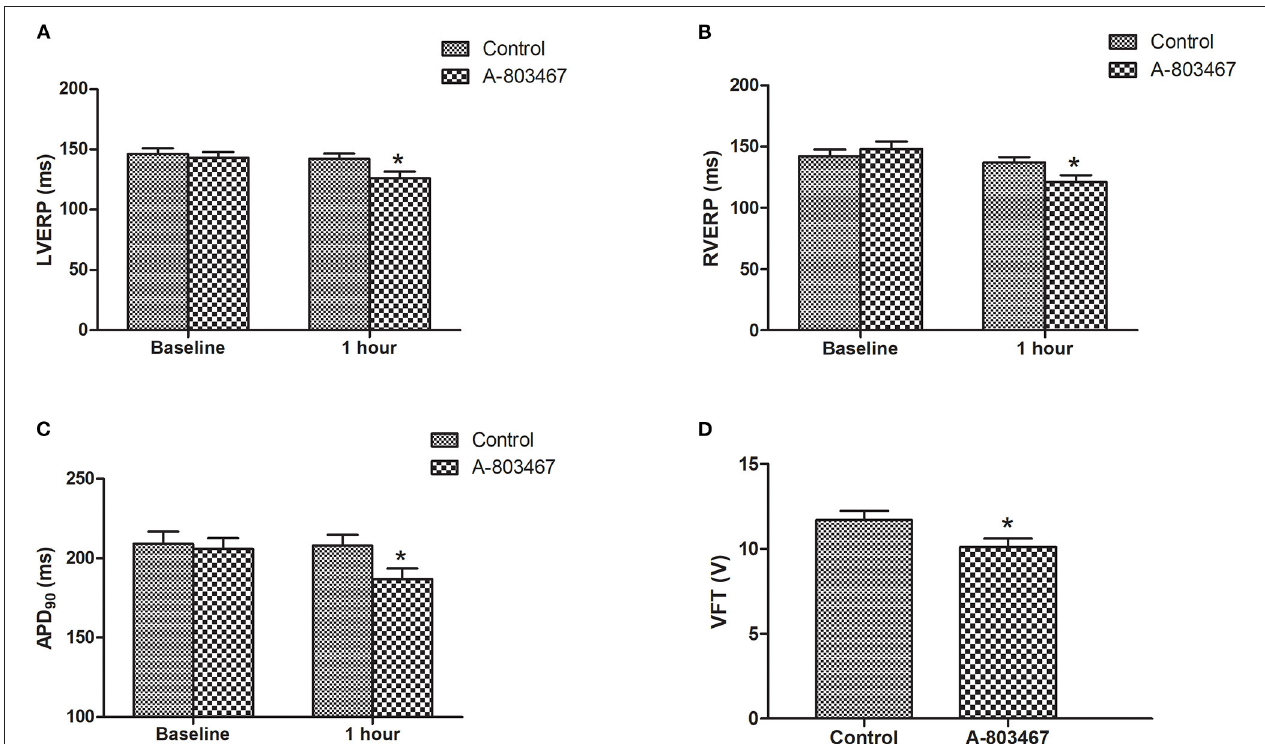
FIGURE 2 | Effects of A-803467 on Ventricular electrophysiology in the both two groups. (A) The left ventricular effective refractory period (LVERP) was decreased in the A-803467 group compared to control. (B) The right ventricular effective refractory period (RVERP) was decreased in the A-803467 group compared to control. (C) A-803467 significantly shortened 90% of action potential duration (APD 90 ) at 1h after LAD occlusion. (D) The ventricular fibrillation threshold (VFT) was significantly shorter in the A-80467 group compared to control. * P < 0.05 vs. Control